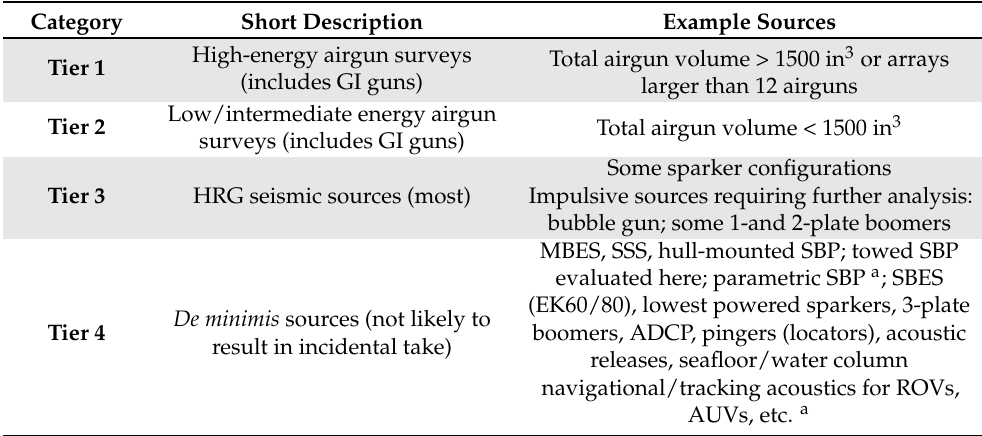
Table 3. Proposed tiering of controlled active marine acoustic sources based on their impact on marine mammals. Marine vibrators are not listed